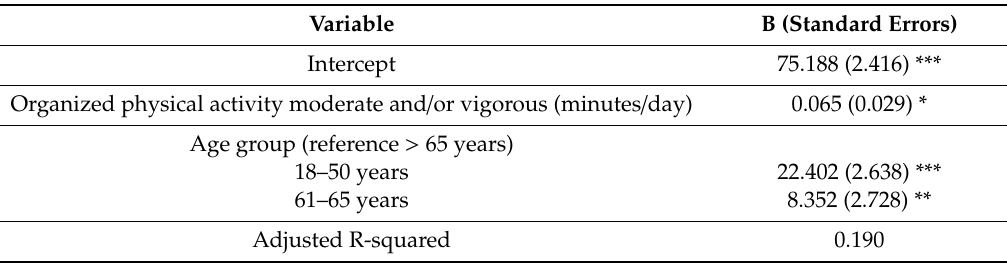
Table 7. Determinants of SI (sti ff ness